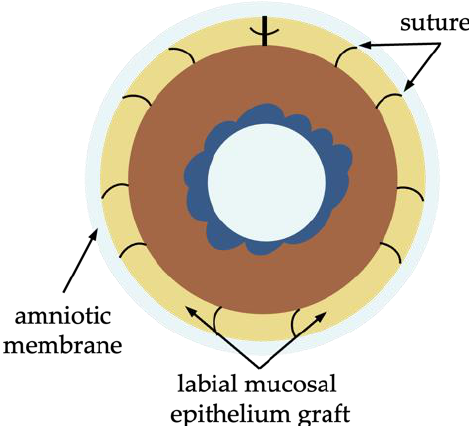
limbus after pannus release (Figure 11). Variations of the technique include circumferential trephination of the lip mucosa [74], application of an amniotic membrane as an overlay, and fibrin glue [75].